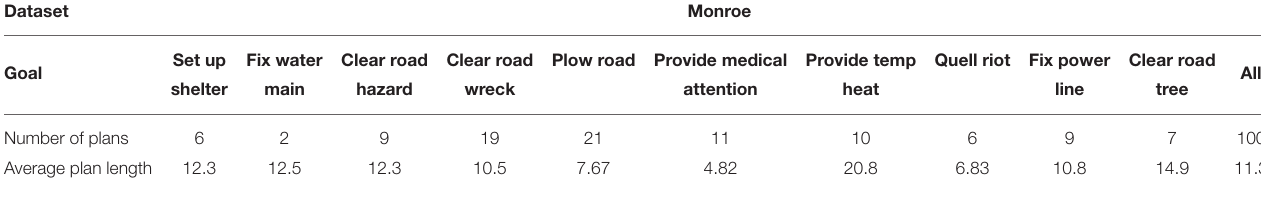
TABLE 2 | Metrics and measures for the Monroe dataset used in our experiments.